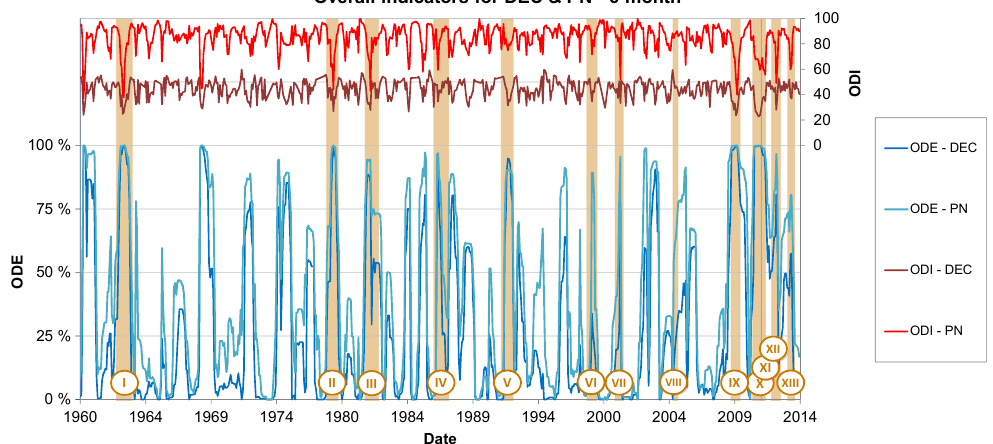
Figure A6. ODE and ODI values using the 6-month timescales of DEC and PN indices, compared with the 13 detected historical droughts (in